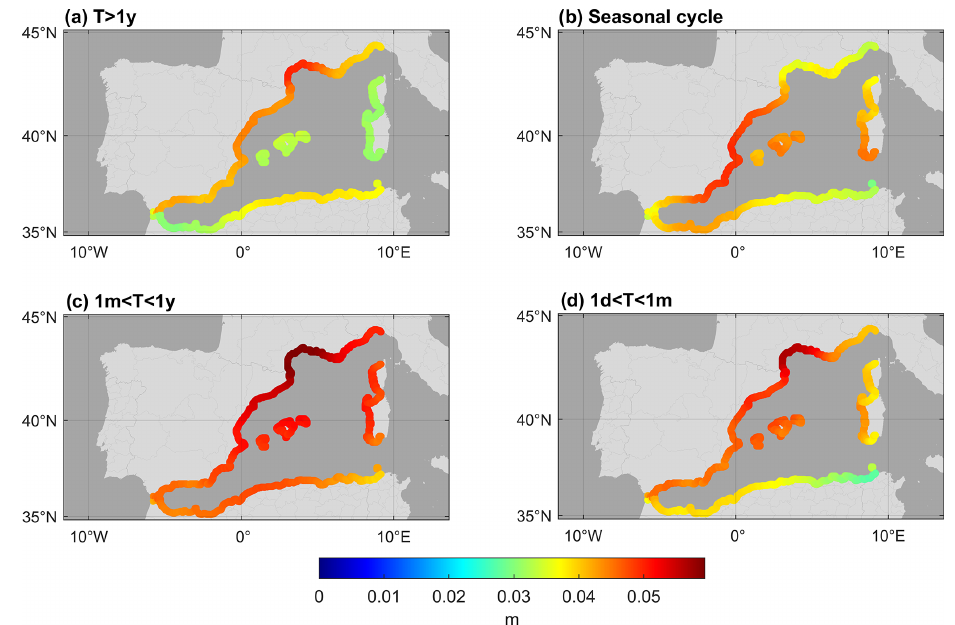
Figure 10. (a) Standard deviation of the reconstructions for the band T > 1 y , with the seasonal cycle subtracted. (b) Standard deviation of the seasonal cycle adjusted from the reconstructions. (c) Standard deviation of the reconstructions for the band 1 m<T < 1 y , with the seasonal cycle subtracted. (d) Standard deviation of the reconstructions for the band 1 d<T < 1 m , with the seasonal cycle